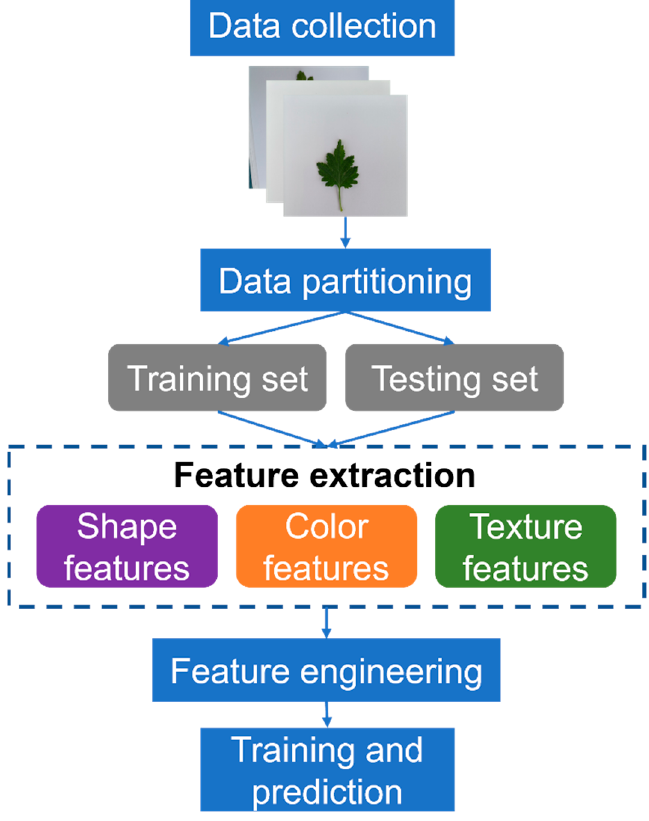
Figure 1. The architecture of the framework highlighting comprehensive guidance for our overall study.